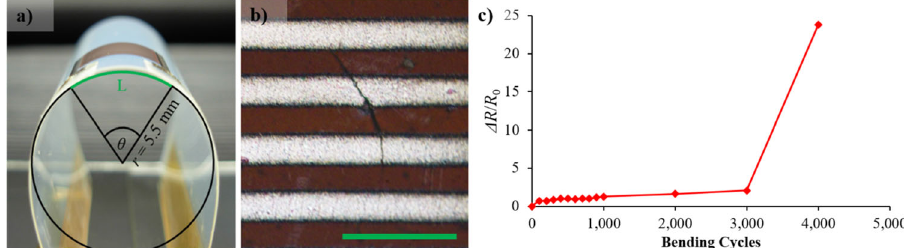
Fig. 5 Characterization of the bolometer devices under bending tests. a Illustration showing 5.5 mm bending radius used in bending cycle tests. b Photograph of crack formation in the device after 3000 bending cycles. (scale bar = 100 μ m) c Change in resistance of the P = 50 µm bolometer devices following bending